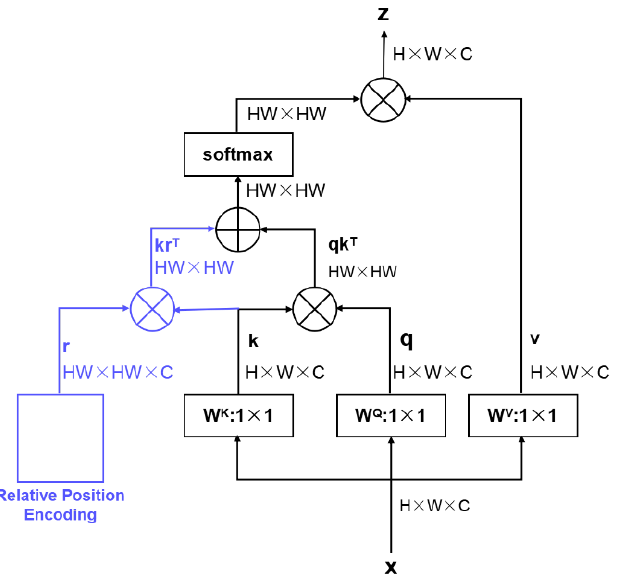
Figure 5. Process of adding the relative position encoding.